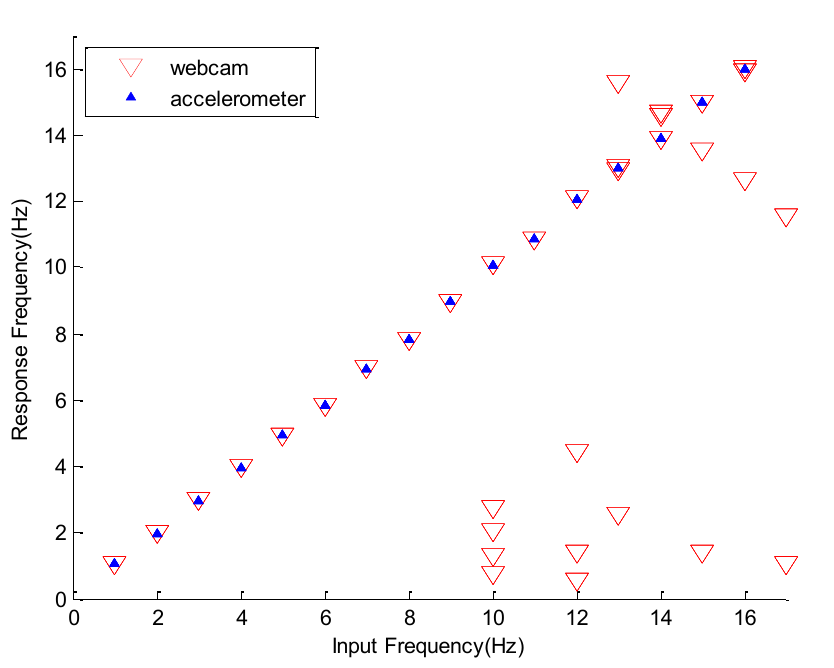
Figure 12. Significant mode captured by webcam and accelerometer, the amplitude of exciter’s vibration is 0.536 mm.